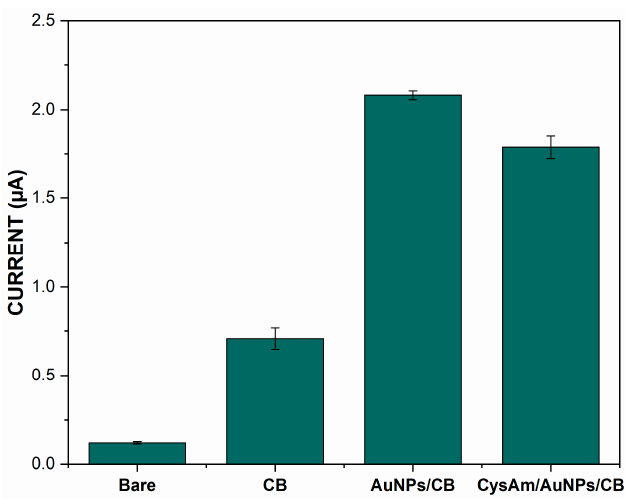
Figure 2. Differential pulse voltammetry reduction current of MB on bare PGE (RSD% = 5.55%), CB/PGE (RSD% = 8.43%), AuNPs/CB/PGE (RSD% = 1.19%), and CysAm/AuNPs/CB/PGE (RSD% = 3.73%) after incubation 20 µM MB at Tris-HCl buffer (20 mM, pH 7.00) including 20 mM NaCl for 5 min and washing with the same buffer including 20 mM NaCl (n = 3).